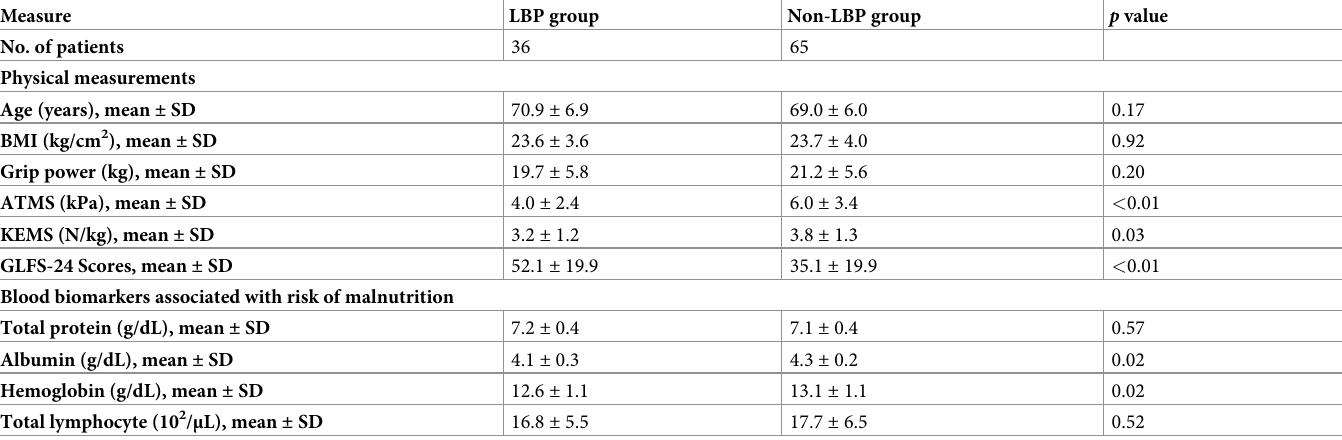
Table 2. Univariate analysis of differences between the LBP and non-LBP groups.